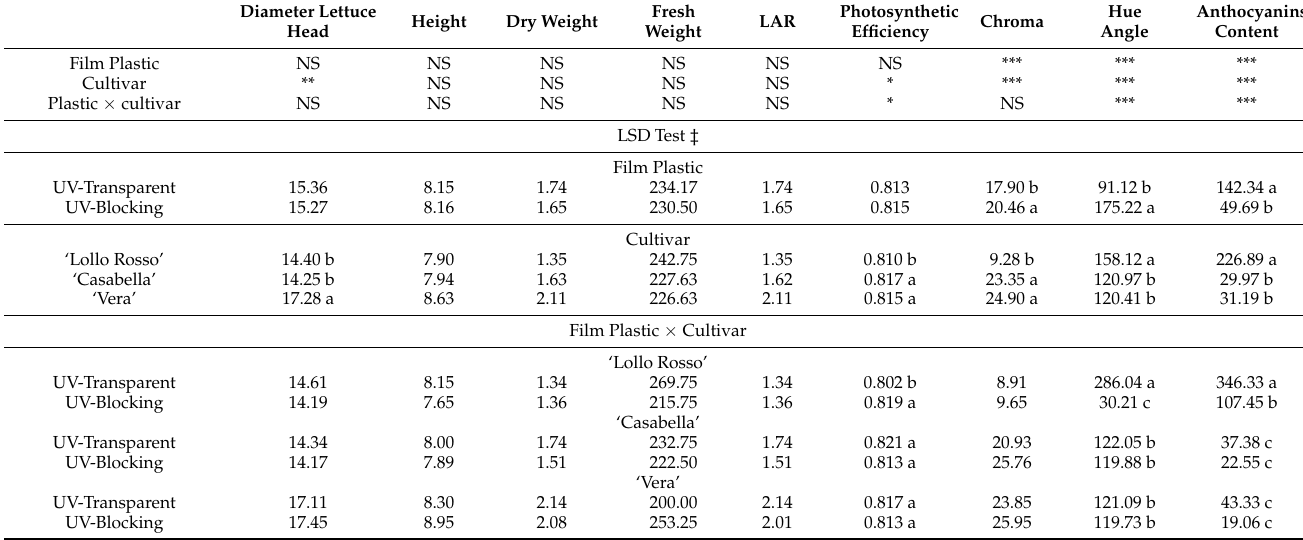
Table 1. Growth and quality parameters of lettuce as affected by film plastic and